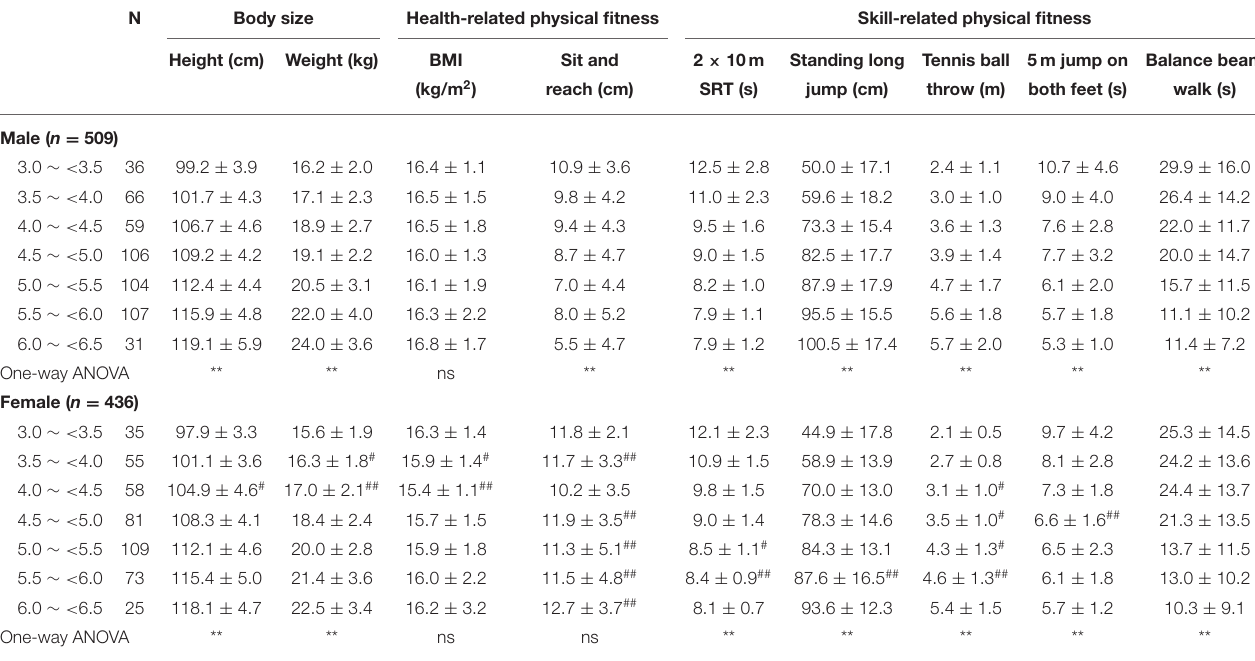
TABLE 1 | Descriptive statistics for body size, physical fitness by gender and chronological age. N Body